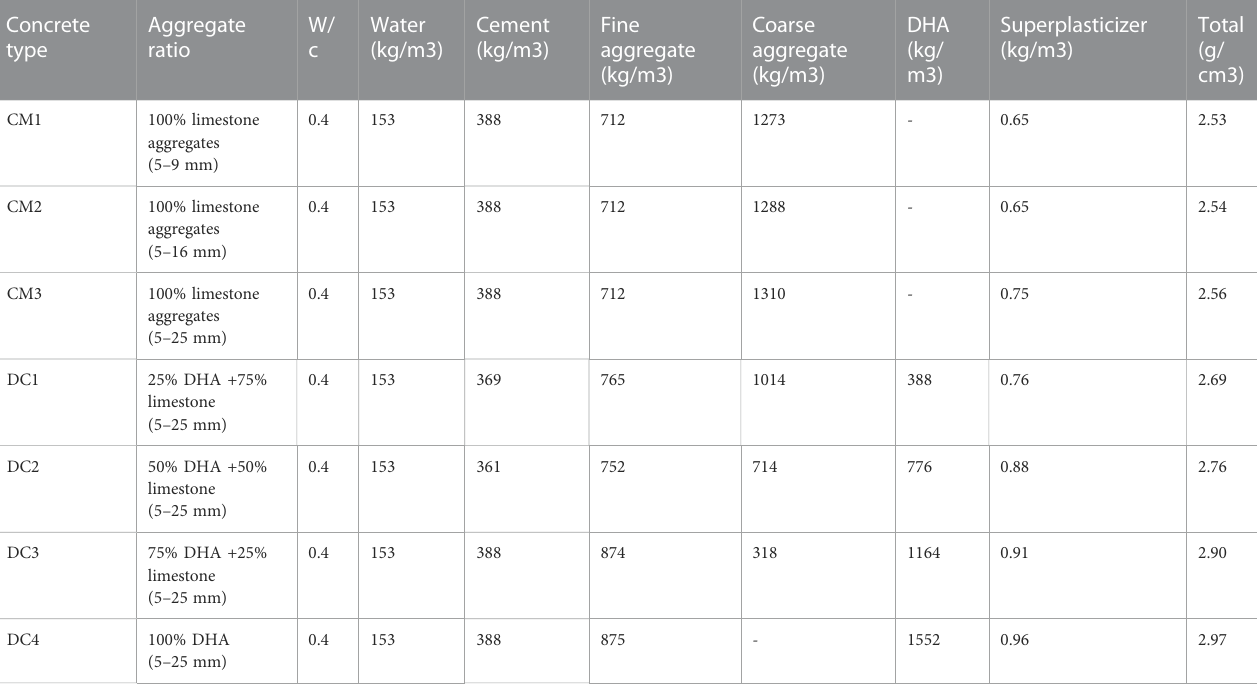
TABLE 3 Mix design of control and DC